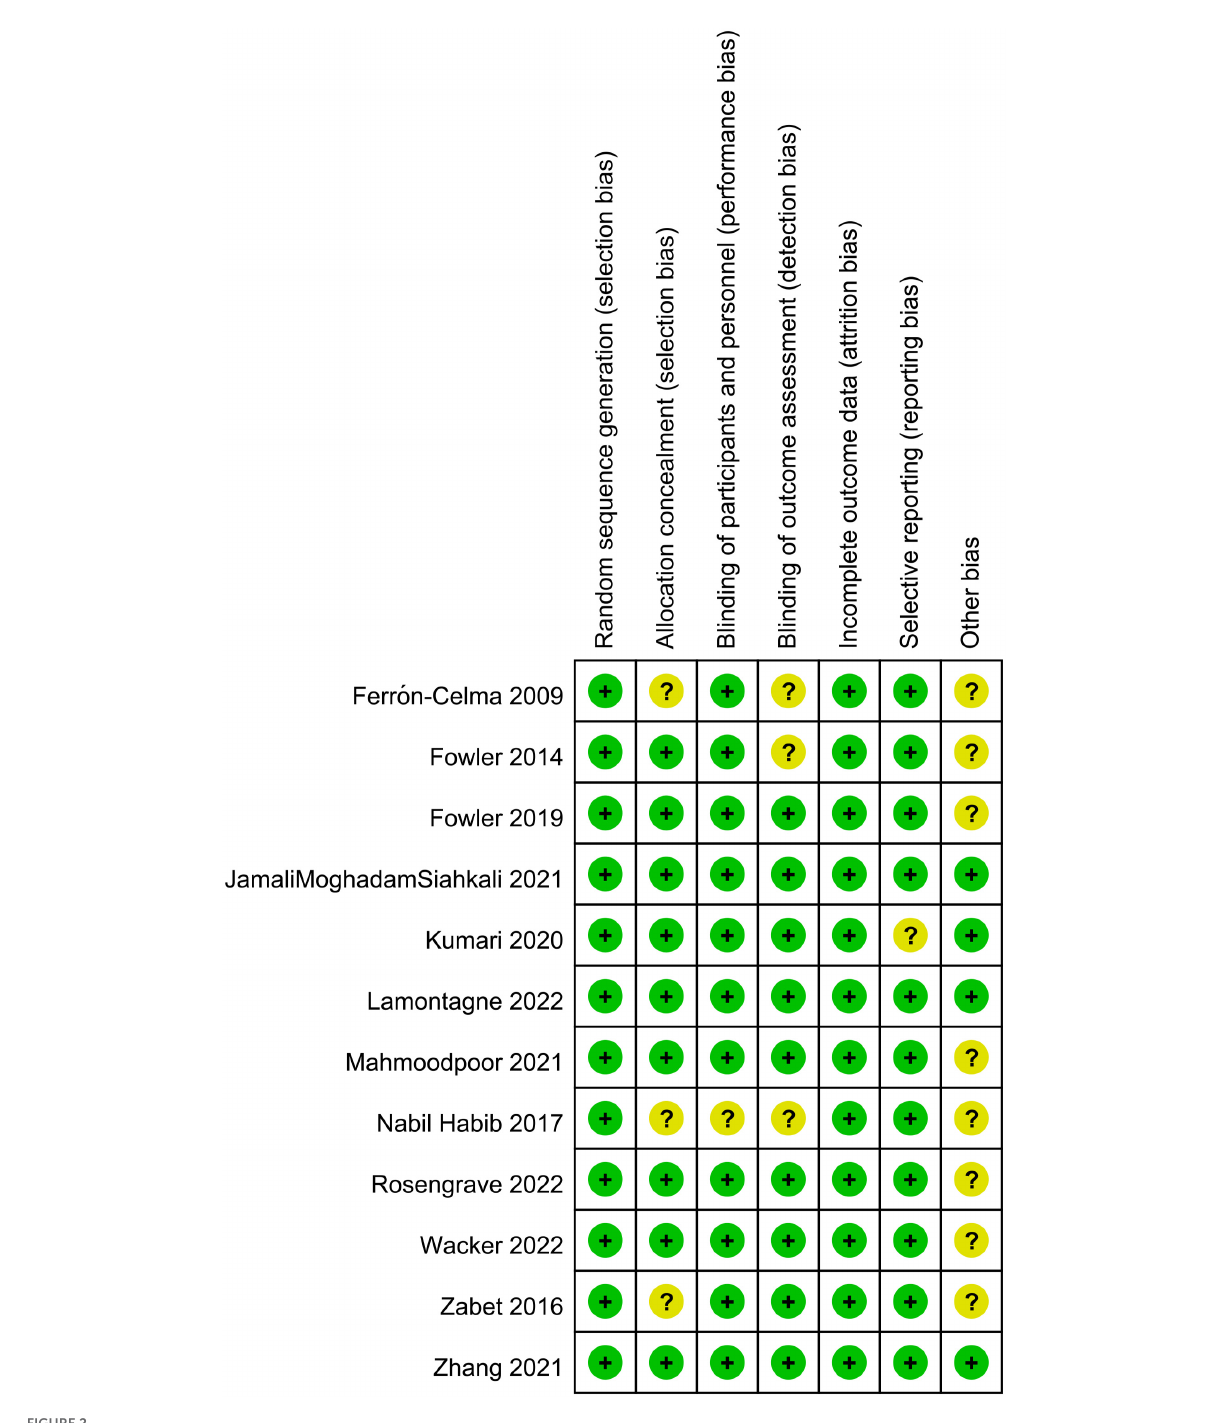
FIGURE2 Risks of bias of the included randomized controlled